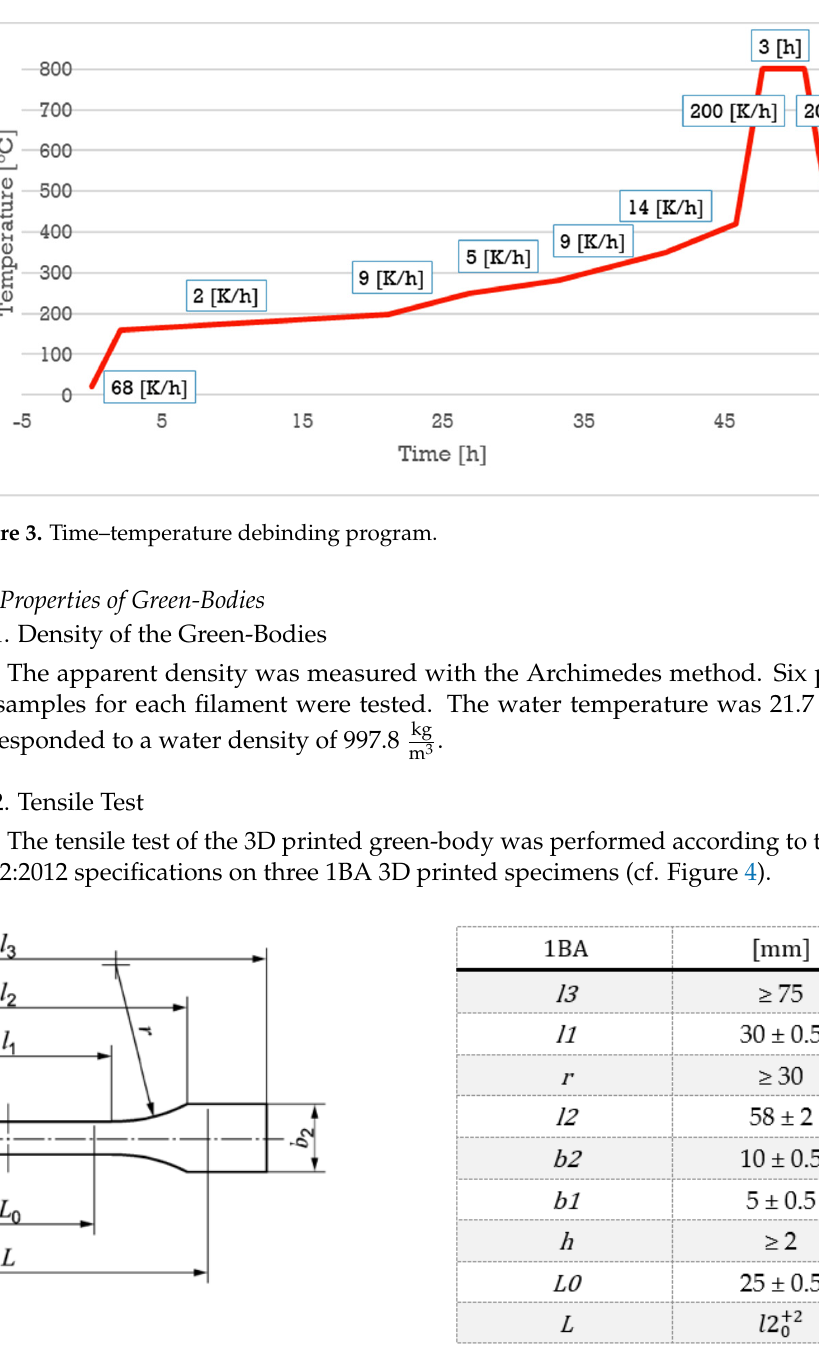
Figure 4. Geometry and dimensions of 1BA EN ISO 527-2:2012 tensile test specimen [19]